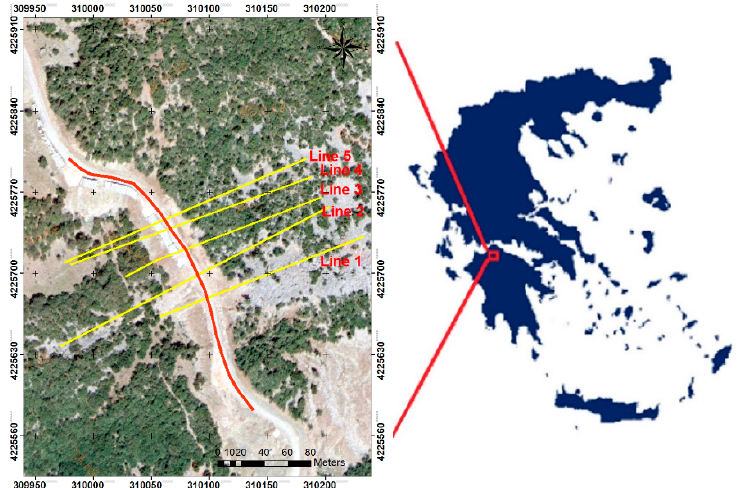
Figure 1. Slope profiles used in RocFall analysis regarding Moira region. The slope picture is taken from Greek Cadastral (2008). Table 2. Geological and material characteristics.